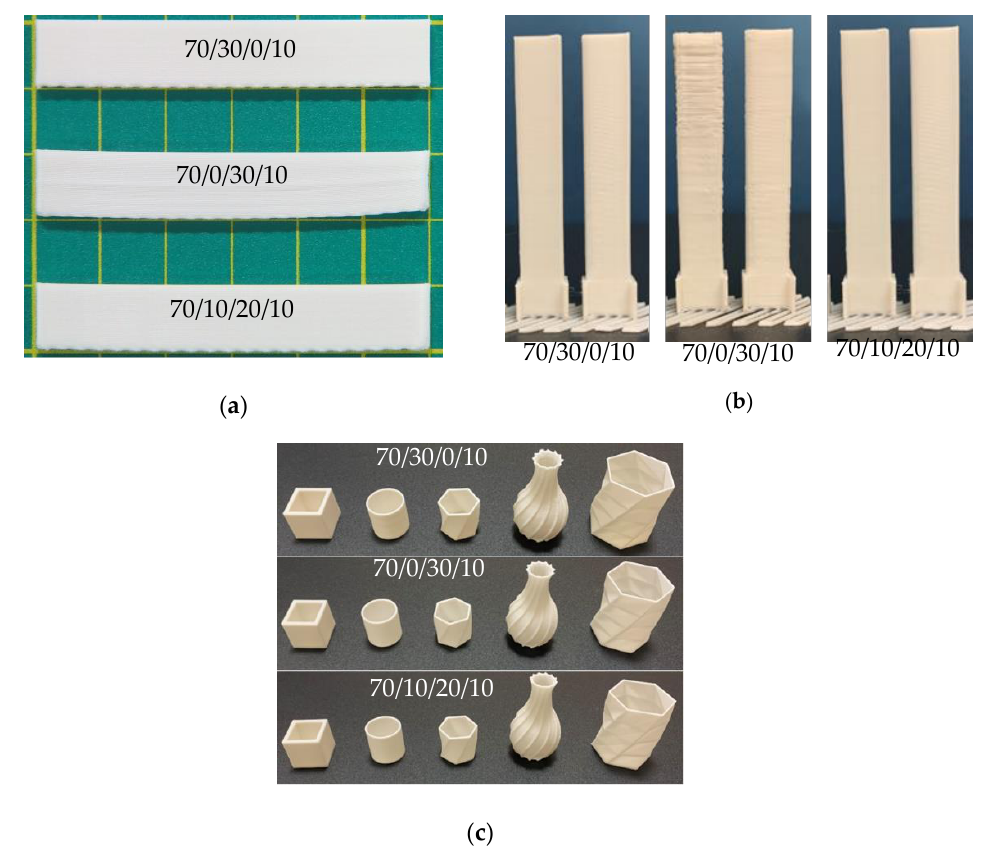
Figure 12. The distortion of 3D printing bars: ( a ) Horizontal direction; ( b ) Vertical direction; and ( c ) 3D printing models of PLA/PBAT/PBS/nano talc composites.